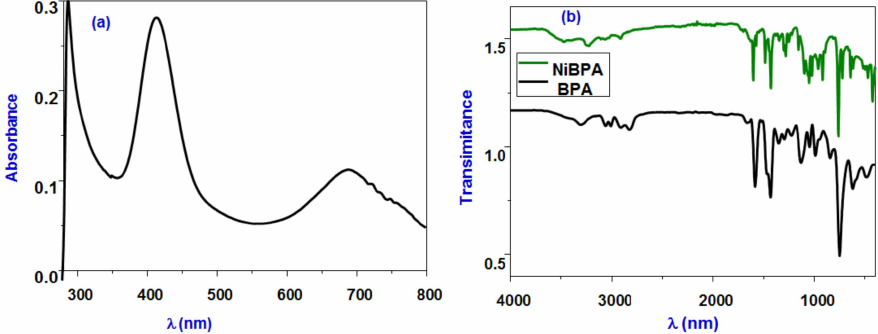
Figure 1. ( a ) UV-vis absorption spectrum of NiBPA ; ( b ) FT-IR spectra of BPA and NiBPA .